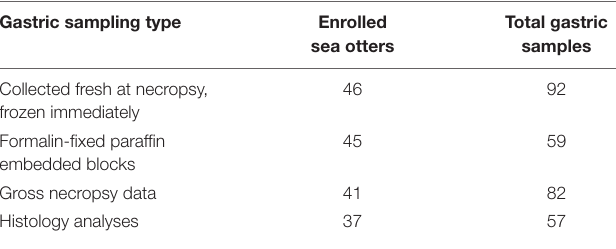
TABLE 1 | Number of enrolled sea otters and total samples based on gastric sampling type.